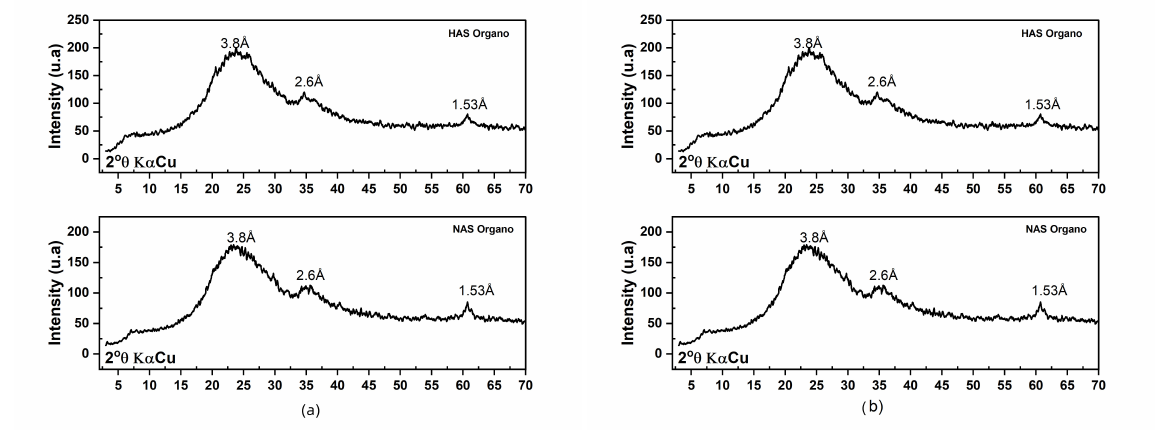
Figure 9. X-ray curves of clays after swelling in ( a ) ethyl alcohol and ( b )